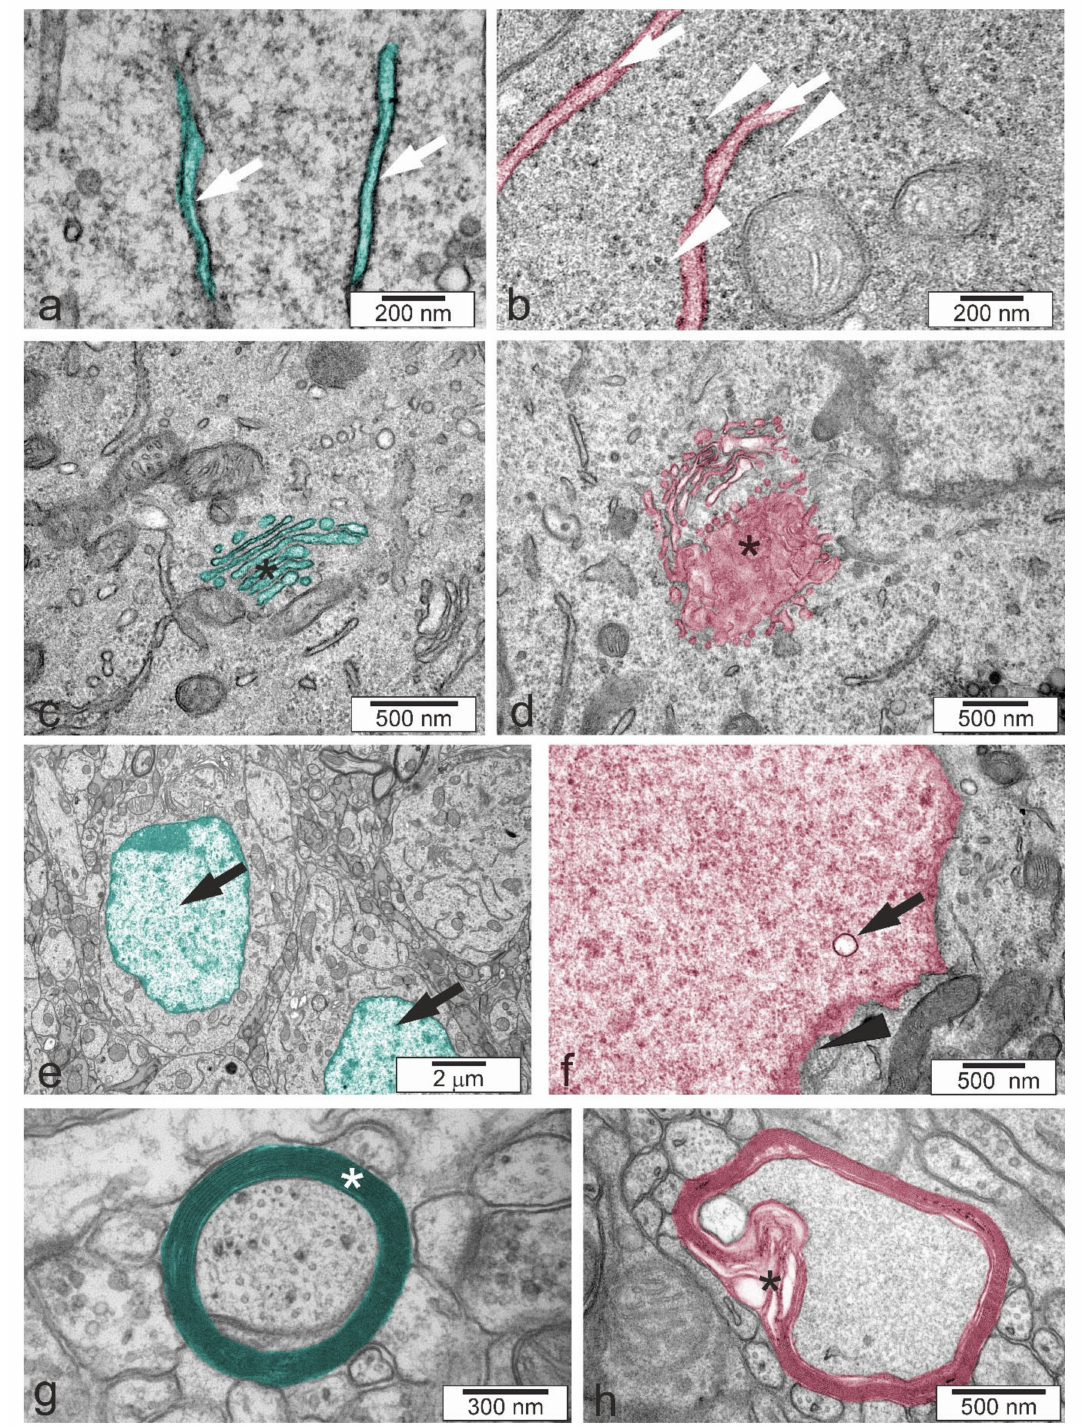
Figure 5. Typical electronograms presenting morphological alterations of neuronal cells in the hippocampus. ( a ) Correct cytoplasm and endoplasmic reticulum (white arrow), ( b ) swollen endoplasmic reticulum (white arrows) and polyribosomes in the cytoplasm (white arrowheads), ( c ) correct Golgi apparatus (black asterisk), ( d ) swollen Golgi apparatus (black asterisk), ( e ) correct nuclei (black arrows), ( f ) vacuolar structures in the cell nucleus (black arrow) and diffused nuclear envelope (black arrowhead), ( g ) correct structure of myelin (white asterisk), and ( h ) delamination of myelin (black asterisk). The colour was used to label control (turquoise) and altered (reddish)